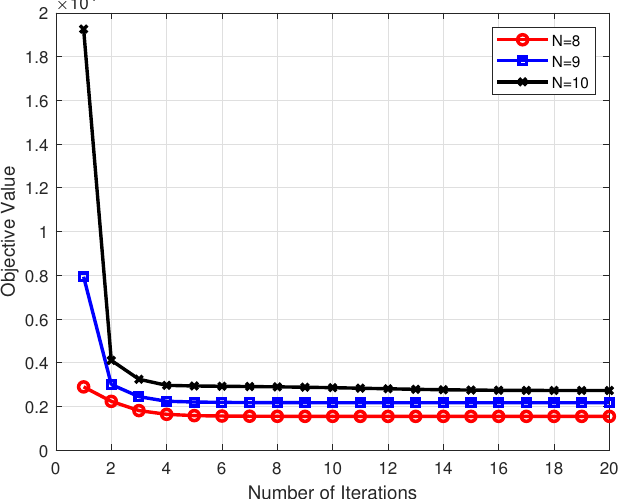
Figure 7. Convergence of the joint optimization-based near-optimal